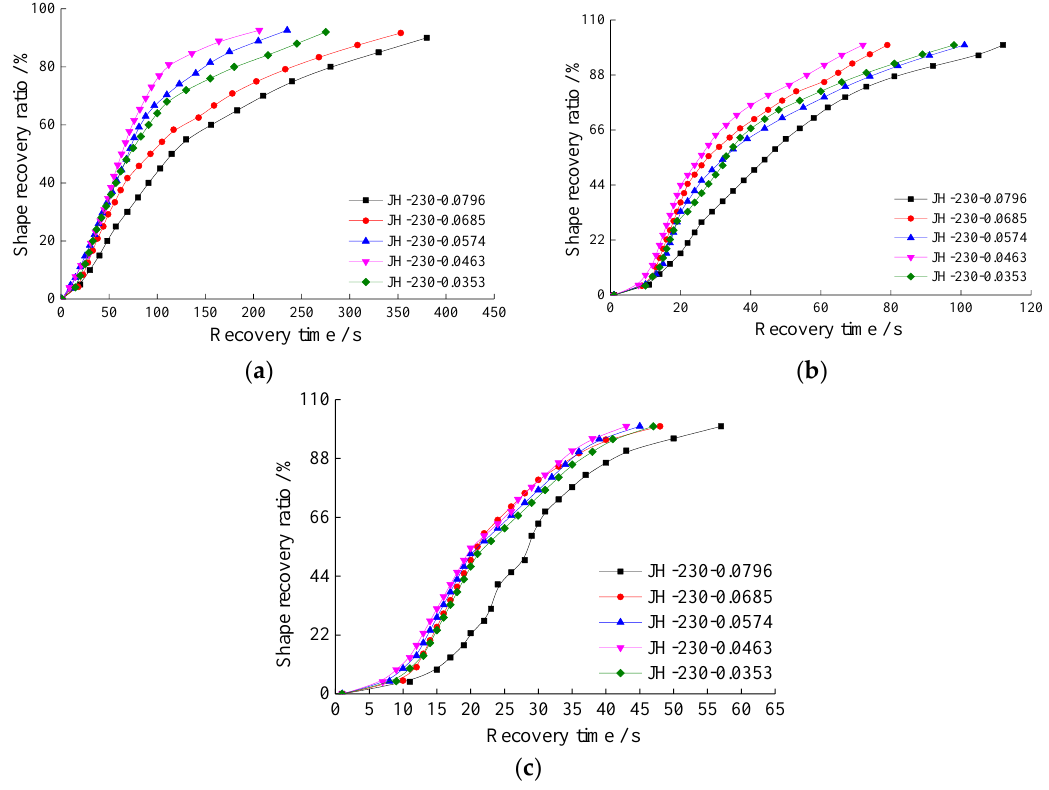
Figure 13. Relationship between the shape recovery ratio and recovery time of the SM-HEP-AM at the same temperature: ( a ) T g °C; ( b ) T g + 10 °C; and ( c ) T g + 20